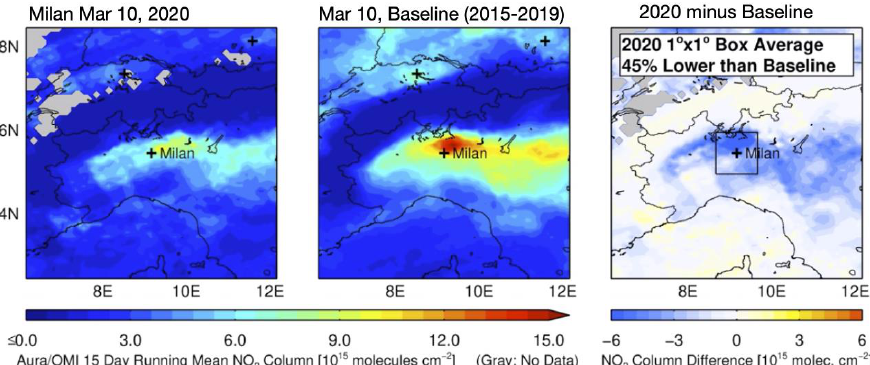
Figure 3. Nitrogen dioxide concentrations over Italy on 10 March of 2020 compared with 10 March of the baseline period (2015 – 2019). Source: Nasa AURA [23].